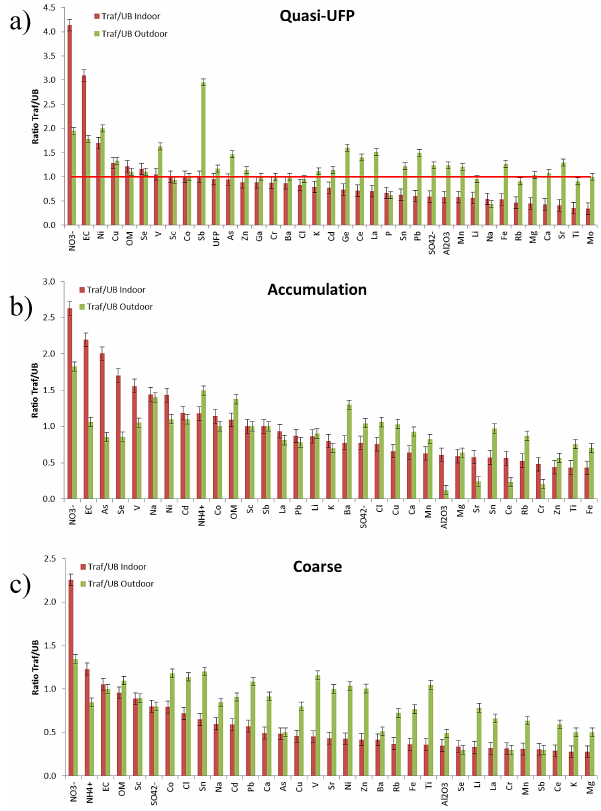
Fig. 4. Mean concentration ratios for concentrations measured at schools located in traffic (Traf) and urban background (UB) envi- ronments, for quasi-UFPs, accumulation and coarse mode